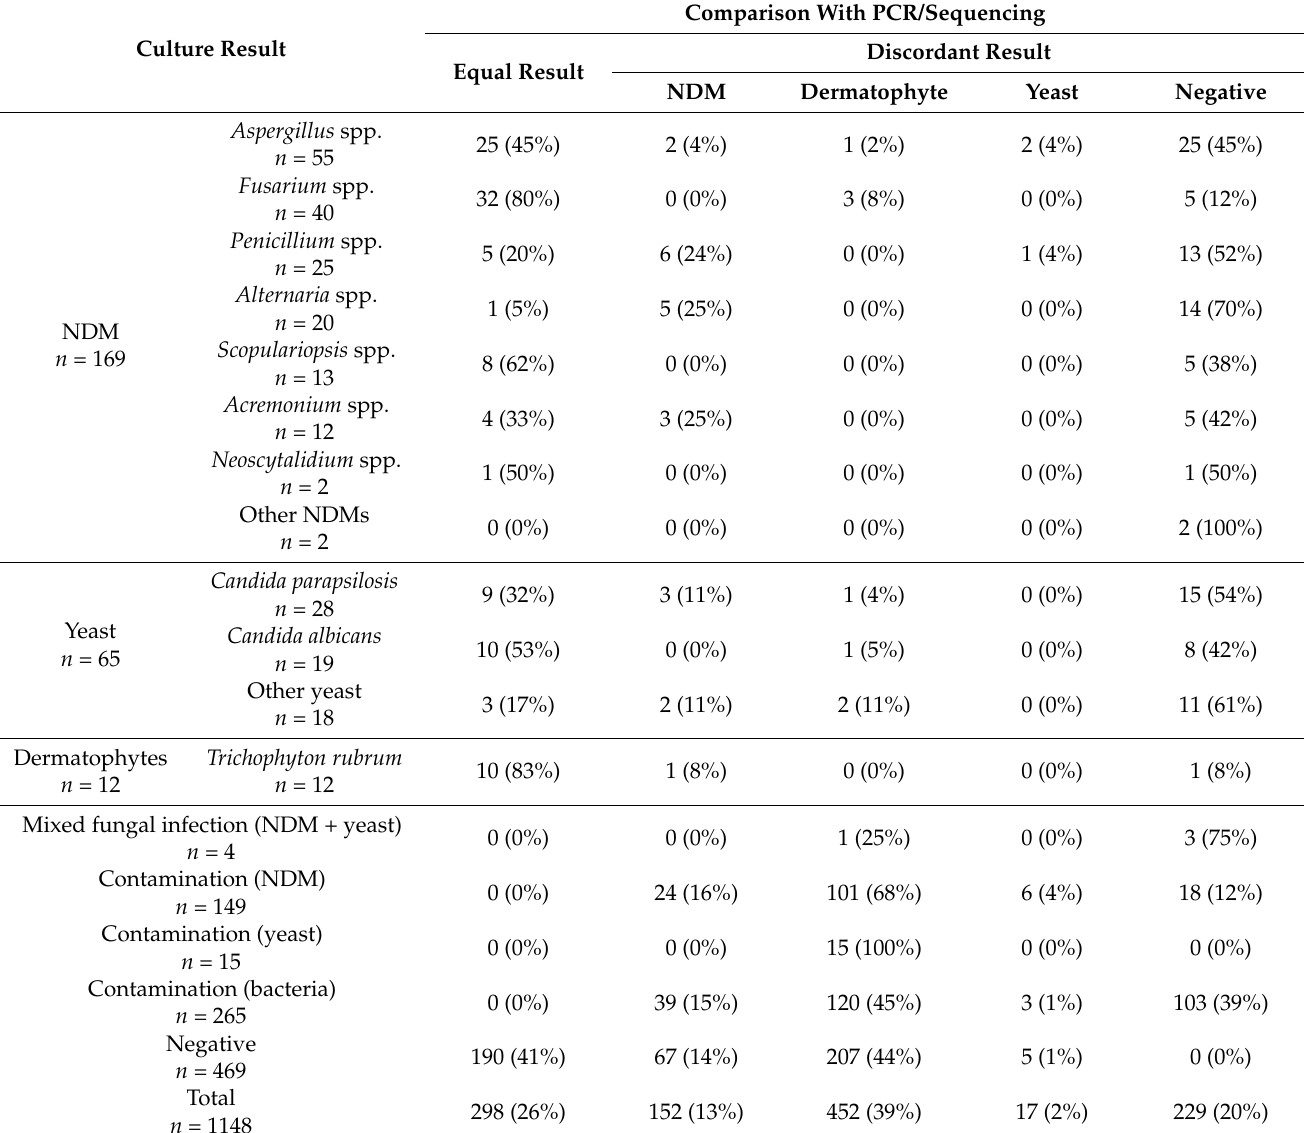
Table 3. Comparison of culture results with their corresponding PCR/sequencing